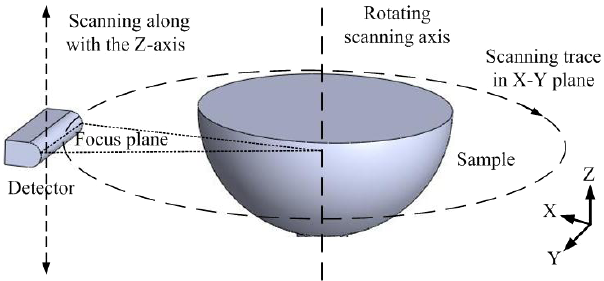
Fig. 1. Schematic of three-dimensional thermoacoustic